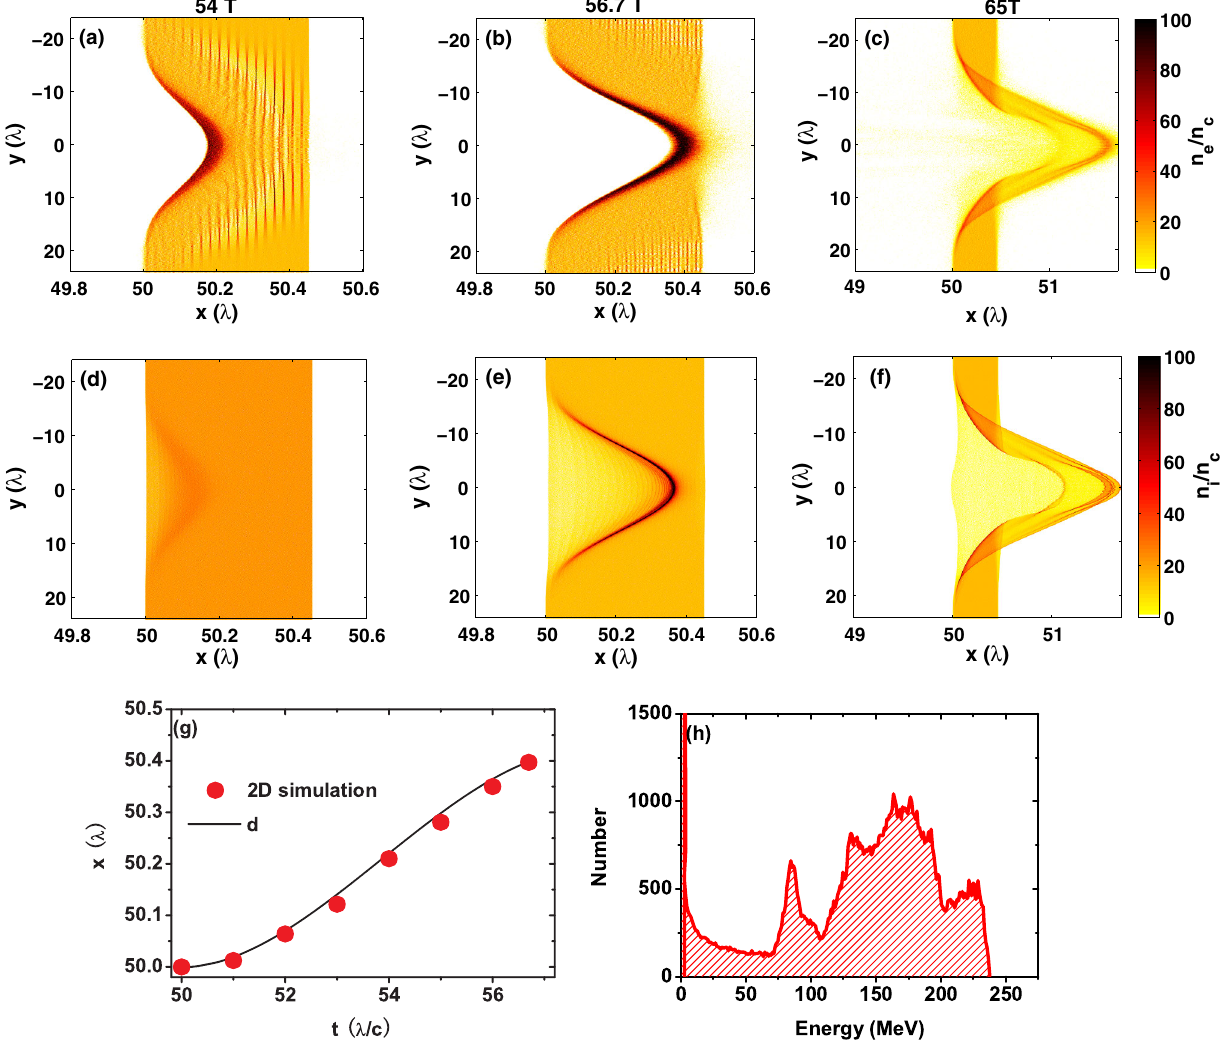
FIG. 7. (a)–(f) 2D simulation results for electron ( n e ) and C 6 þ density at t ¼ 54 T , 56 : 7 T , and 65 T . A fully ionized carbon foil is irradiated by the CP laser pulse at intensity I 0 ¼ 1 : 1 (cid:2) 10 21 W = cm 2 ( a 0 ¼ 20 ), where the foil electron density is 15 n c and the foil thickness is 0 : 45 (cid:3) . (g) CEL position d obtained from the model (solid line) and 2D simulation (solid circle). (h) Energy spectra at t ¼ 65 T for C 6 þ ions in the region j y j < 2 (cid:10) m